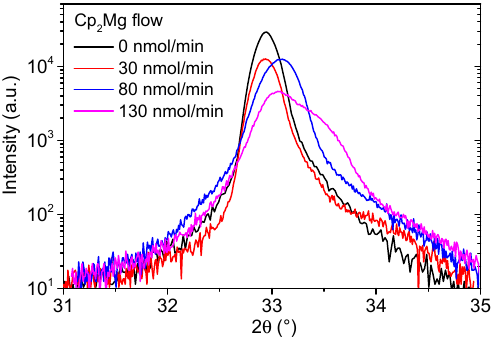
Figure 1. XRD 2 Θ / ω scan of InAlN (0002) XRD diffractions for different Cp 2 Mg flow. Table 1. InAlN layers material parameters for different Cp 2 Mg flow. FWHM refers to 2 Θ / ω scan shown in Figure 1.